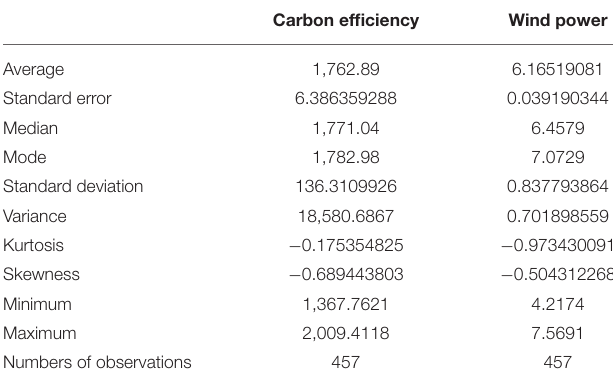
TABLE 2 | Statistical